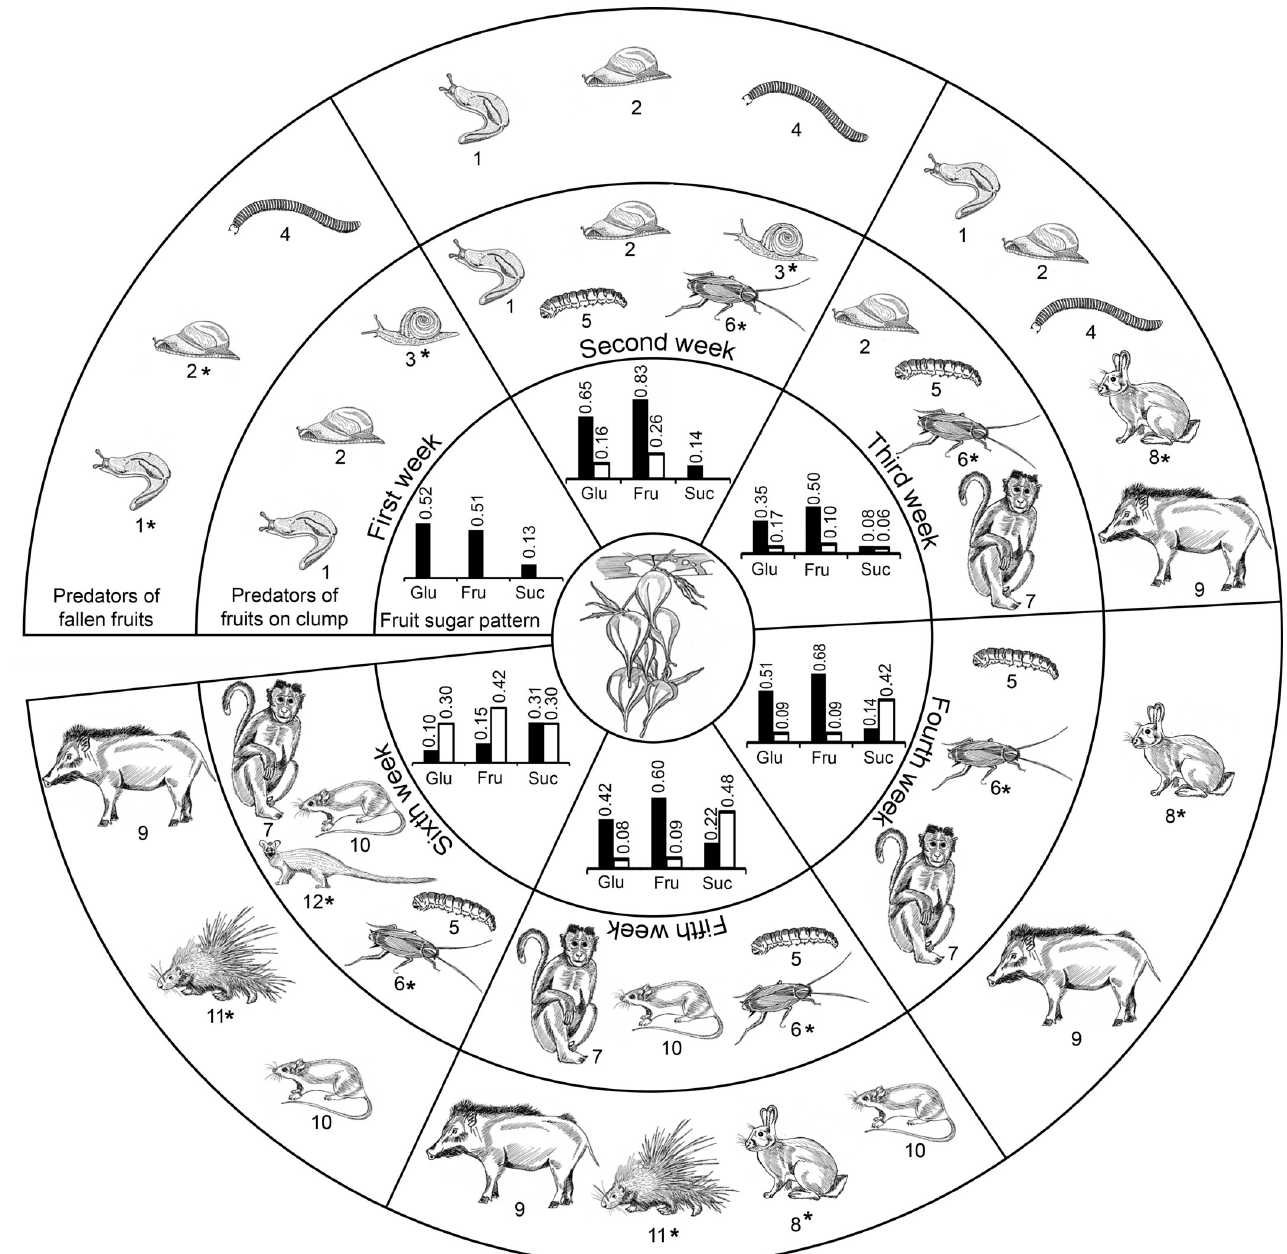
Fig 4. Diagrammatic sketch displaying predation on M . baccifera fruits and their sugar profiles. Predators : 1. Slug, M . dussumieri ; 2–3. Snails, 2. C . bistrialis , 3. Macrochlamys sp.; 4. Millipede, S . colosseus; 5–6. Borer larvae, 5. A . grisella , 6. B . germanica ; 7–12 Mammals, 7. Bonnet macaque, M . radiata , 8. Indian hare, L . nigricollis , 9. Wild boar, S . scrofa , 10. Rats, R . rattus , 11. Porcupine, H . indica , 12. Palm civet, P . hermaphroditus . Rabbits ( L . nigricollis ) and deers ( A . axis ) (not in figure) are primarily seedling predators and occasionally frugivorous (Table 1 and S10 Table in S1 File). � Infrequent visitors. Sugar pattern , predators : 1 st week: fruit pericarp Glu 0.52%, Fru 0.51%, Suc 0.13%, (predators 1–4), (no fruit liquid in first week); 2 nd week: fruit pericarp Glu 0.65%, Fru 0.83%, Suc 0.14%, fruit liquid Glu 0.16%, Fru 0.26%, Suc 0.00%, (predators 1–6); 3 rd week: fruit pericarp Glu 0.35%, Fru 0.50%, Suc 0.08%, fruit liquid Glu 0.17%, Fru 0.10%, Suc 0.06% (predators 1–2, 4–9), 4 th week: fruit pericarp Glu 0.51%, Fru 0.68%, Suc 0.14%, fruit liquid Glu 0.09%, Fru 0.09%, Suc 0.42% (predators 5–9), 5 th week: fruit pericarp Glu 0.42%, Fru 0.60%, Suc 0.22%, fruit liquid Glu 0.08%, Fru 0.09%, Suc 0.48% (predators 5–11), 6 th week: fruit pericarp Glu 0.10%, Fru 0.15%, Suc 0.31%, fruit liquid Glu 0.30%, Fru 0.42%, Suc 0.30% (predators 5–7, 9–12) (details of fruit sugar pattern in Govindan et al [9]).